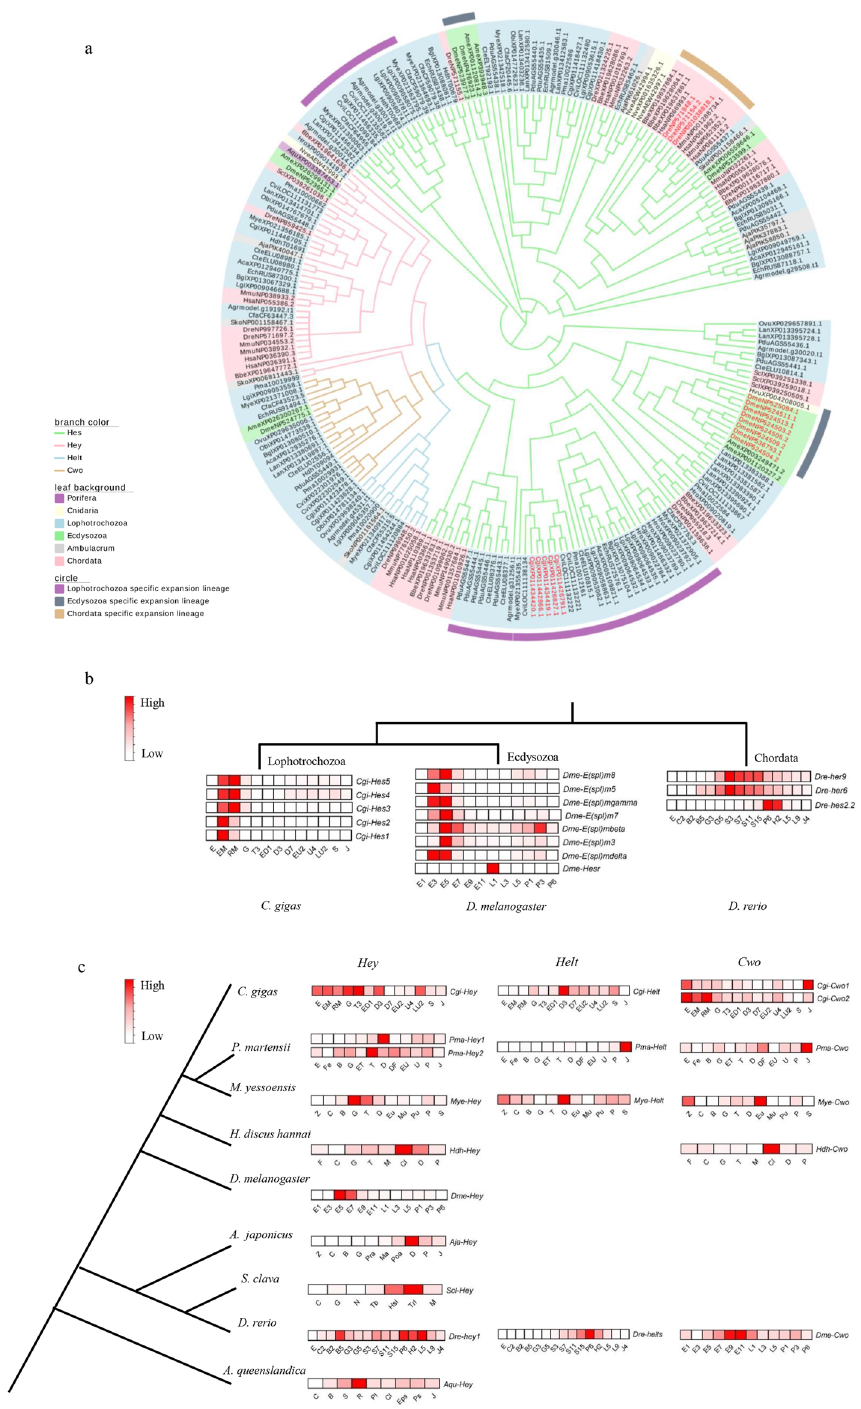
Figure 5. Phylogeny and transcriptome of Hes/Hey -related gene family across metazoans. ( a ) A phylogenetic tree was constructed by aligning the bHLH domain of 233 genes. Red labels indicate expanded Hes gene clusters that are analysed in ( b ). ( b ) Transcriptomic data of expanded Hes gene clusters in lophotrochozoan, Ecdysozoa, and Chordata. ( c ) Transcriptomic data of Hey , Helt , and Cwo in nine species. Sequence IDs are shown in Supplementary Table S3. bHLH domain protein sequences are given in Supplementary Data S3. Developmental point and species name abbreviations are described in Supplementary Table